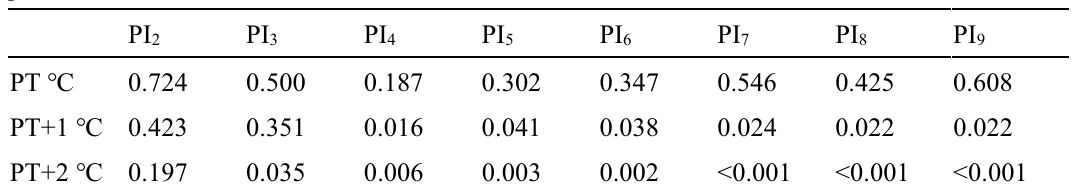
Figure 4. TSSP response patterns in chronic pain patients (female only; n = 16). Open circle showed that PI n was significantly higher than PI 1 . Pain Intensity (PI n ) was calculated by integrating the values of pain ratings from the nth stimulus to the n + 1th